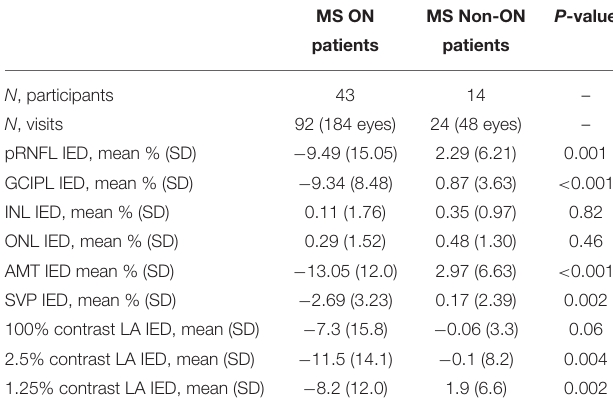
TABLE 3 | Inter-eye differences in OCT, OCTA, and visual function measures in MS ON vs. MS non-ON